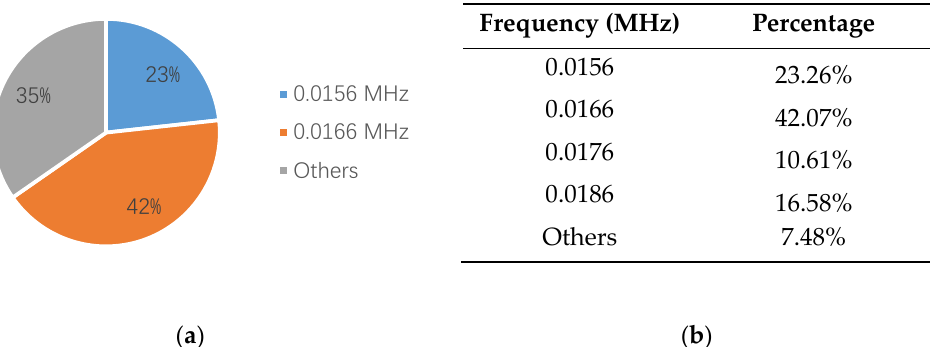
Figure 14. The frequency proportion between 0.01–0.02 MHz in the second specimen: ( a ) pie chart; ( b ) table.